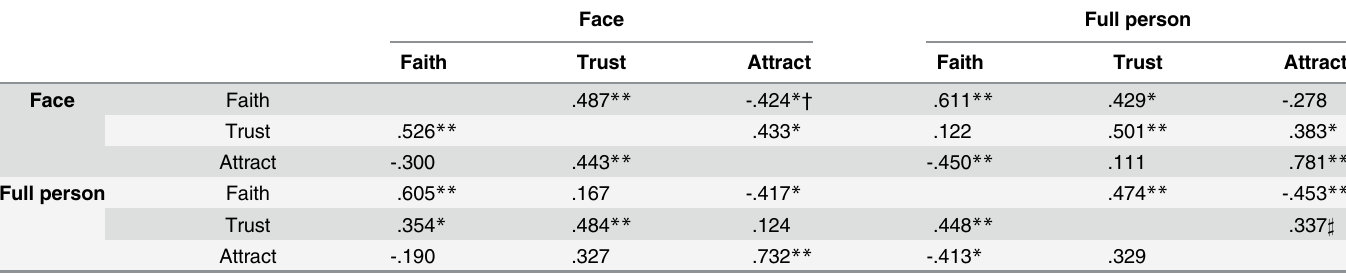
Table 1. Correlations between ratings of faithfulness, trustworthiness and attractiveness made from face and full person images (Pearson ’ s r are shown above the diagonal and Spearman ’ s r shown below the diagonal for comparison)